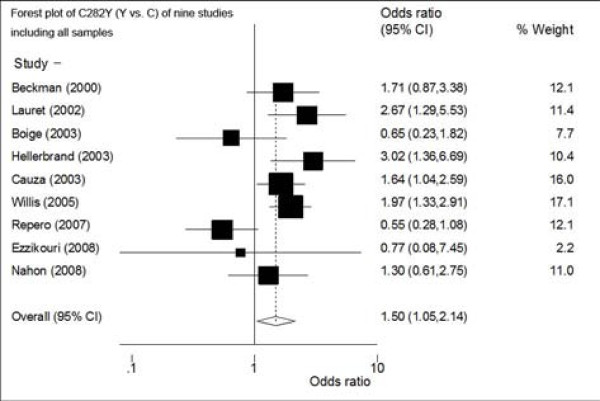
Forest plot of the RE ORs and 95% CIs of the association between HCC and the C282Y mutation (Y vs. C) of nine studies. The combined estimate is indicated by the diamond. The solid vertical line represents the null result.